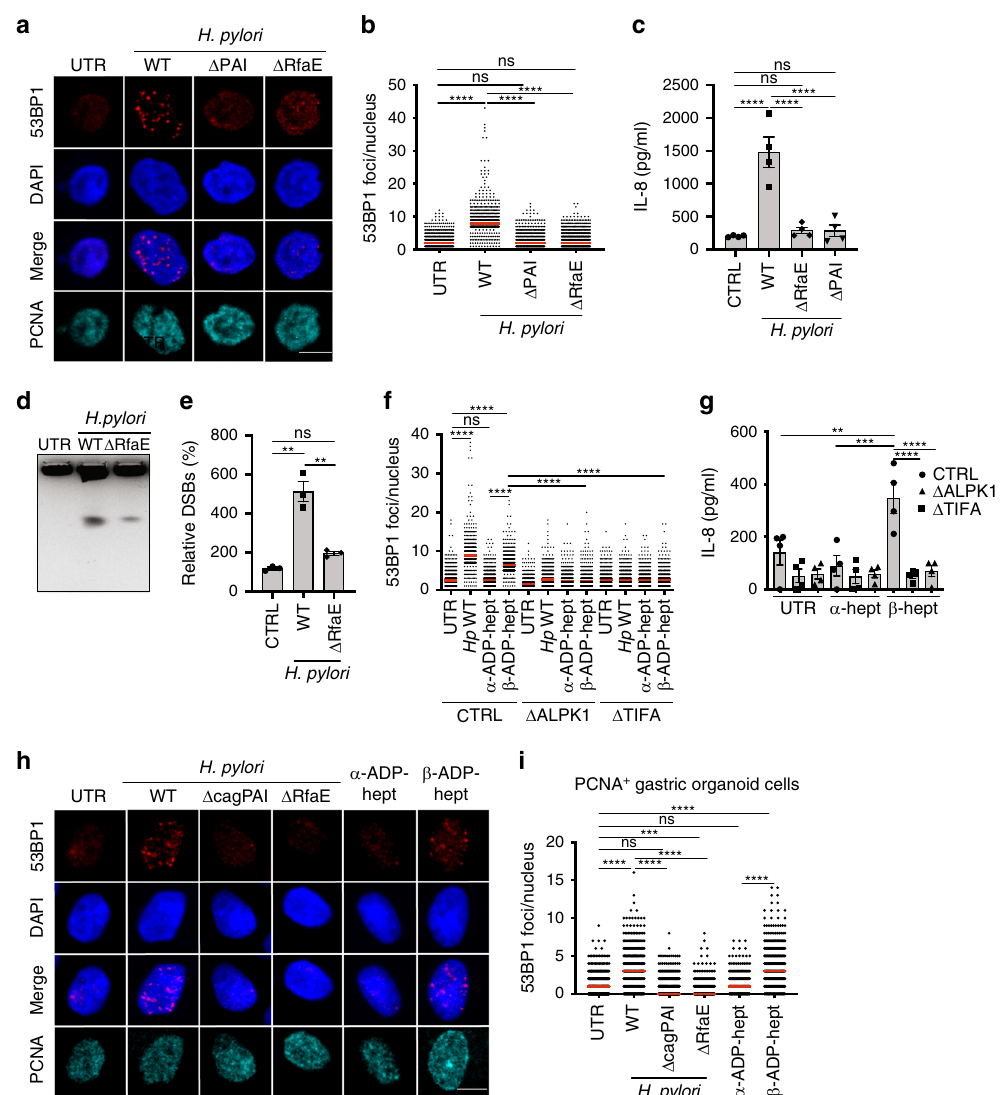
Fig. 3 The bifunctional RfaE enzyme is required, and its product β -ADP-heptose is suf fi cient for the induction of DNA DSBs. a – c AGS cells were infected for 6 h with H. pylori P12 or its isogenic RfaE and Cag-PAI mutants at an MOI of 50 and subjected to immuno fl uorescence staining for 53BP1 and PCNA as well as DAPI. Representative images are shown in a alongside scatter dot plots of >730 and up to 1655 cells per condition in b . IL-8 secretion as assessed by ELISA is shown in c . Data in b and c are pooled from four independent experiments. Red lines indicate medians. Data in c are represented as mean + / − SEM of four independent experiments. Scale bar in a , 10 μ m. d , e AGS cells were infected for 6 h as described above and subjected to PFGE. A representative gel is shown in d alongside the quanti fi cation of three gels (independent experiments) in e . Fragmented DNA was normalized to the intact DNA retained in the slot, and to the uninfected control condition, which was set as 100%. Data are presented as mean values + / − SEM. f , g Wild-type (CTRL), ALPK1-de fi cient ( Δ ALPK1), and TIFA-de fi cient ( Δ TIFA) AGS cells were exposed to α - or β -ADP-heptose at 0.5 μ M fi nal concentration for 6 h and subjected to immuno fl uorescence staining for 53BP1 and PCNA as well as DAPI. Scatter dot plots of >579 and up to 706 cells per condition are shown in f , with red lines indicating medians. IL-8 secretion as assessed by ELISA is shown in g . Data in f and g are pooled from four independent experiments. P -values were calculated by one-way ANOVA with Dunn ’ s multiple comparisons correction. Data in g are presented as mean values + / − SEM. Scale bar, 10 μ m. h , i Gastric organoids were transferred to 2D cultures and infected with the indicated strains of H. pylori P12 (MOI of 50) or exposed to α - or β -ADP- heptose at 0.5 μ M fi nal concentration for 6 h. Cells were subjected to immuno fl uorescence staining for 53BP1 and PCNA as well as DAPI. Representative images are shown in h of 53BP1 foci (scale bar, 10 μ m), alongside scatter dot plots of >298 and up to 603 cells per condition for PCNA + cells (in i ). Data in i are pooled from two independent experiments with cells derived from two different donors. Red lines indicate medians. P -values were calculated by one- way ANOVA with Dunn ’ s multiple comparisons correction. ns, not signi fi cant; ** p < 0.01, *** p < 0.005, **** p < R-loop formation is required for replication stress . Active DNA damage and replication stress induced by H. pylori , we used a cell line that conditionally expresses human RNase H1 41 , an replication and transcription that co-occur in the same regions of the genome can result in replication stress and DNA damage if enzyme that cleaves the RNA strand in RNA/DNA hybrids and both machineries collide. Replication fork stalling at sites of these thereby eliminates R-loops. This cell line is derived from U2OS con fl icts is caused by the formation of co-transcriptional R- osteosarcoma cells that have previously been shown to be sus- loops 38 – 40 . To address whether R-loop formation is the cause of ceptible to H. pylori -induced DNA damage 15,18 and that are